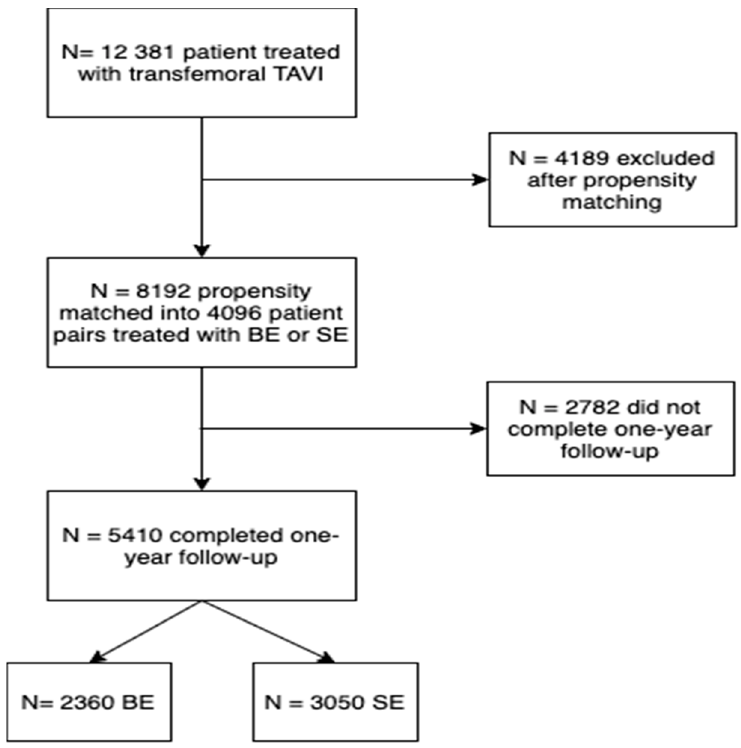
Figure 1. Patient flow chart.